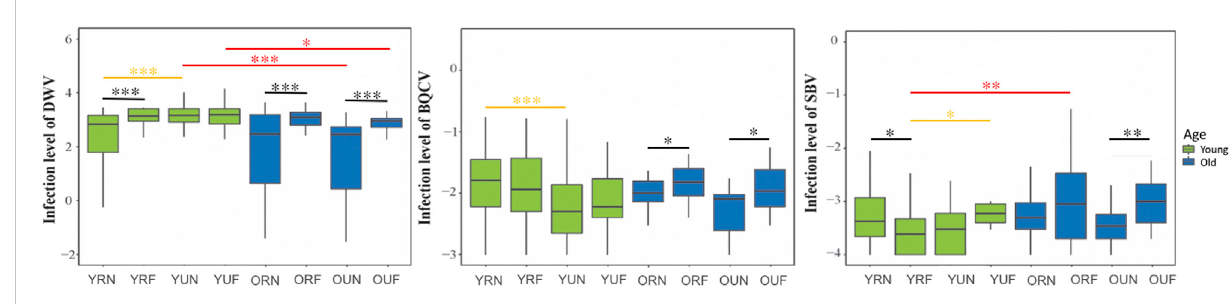
FIGURE 5 Relative levels of honeybee RNA viruses. The y -axes indicate log10-transformed relative levels of DWV, SBV and BQCV relative to Rps5 (control) genemRNAlevel.SamplenotationisasinFigure2.Black,yellowandredasterisksillustratesigni fi cantdifferencesbetweenbehavioral,nutritional,andage